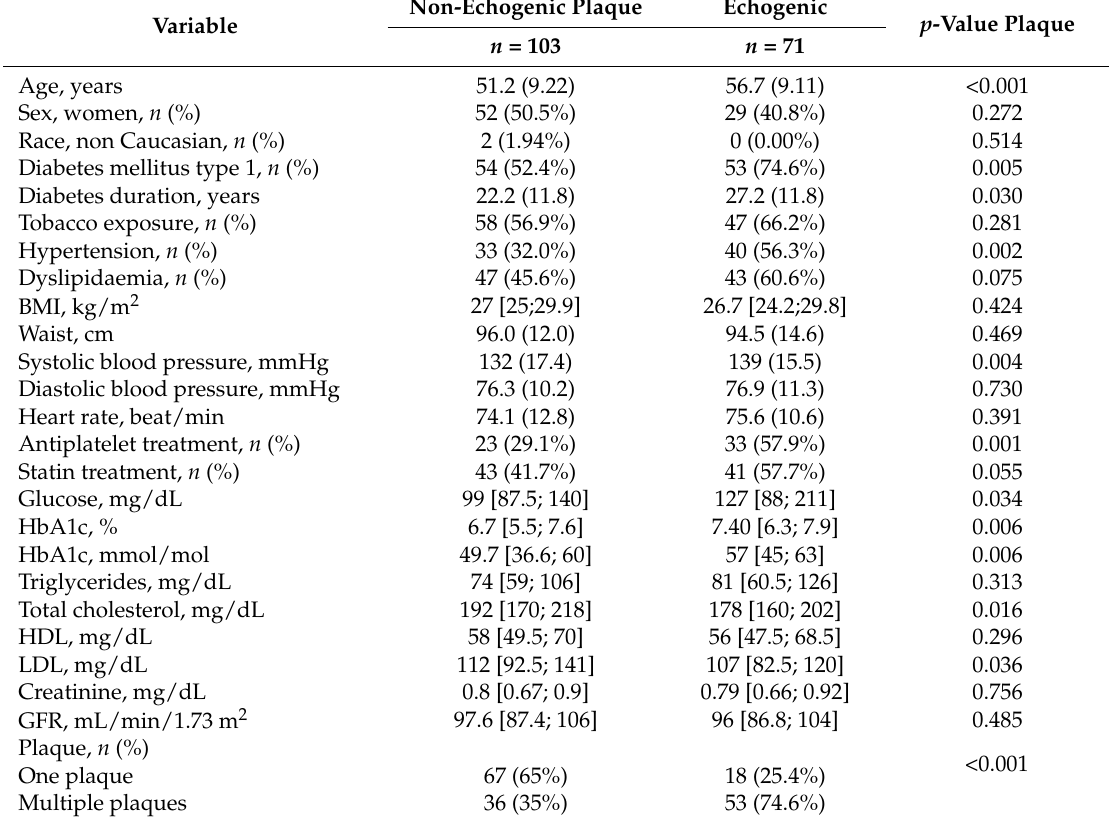
Table A1. Baseline characteristics of the study group according to the presence of echogenic plaques.